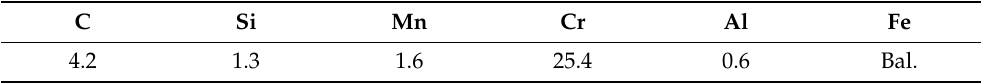
Table 5. Chemical composition of filler material of Lincore 60-O (MF10–GF–60–CG–DIN 8555-83) (in % wt.).